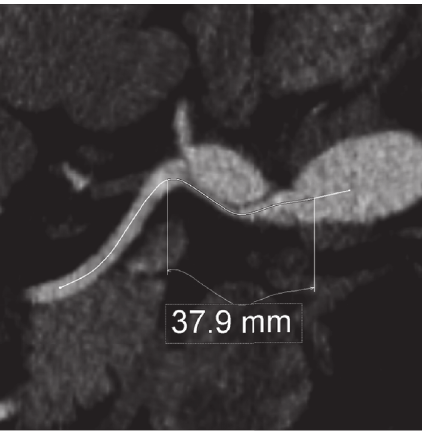
Figure 2: CT angiogram reconstruction of the celiac artery at the time of